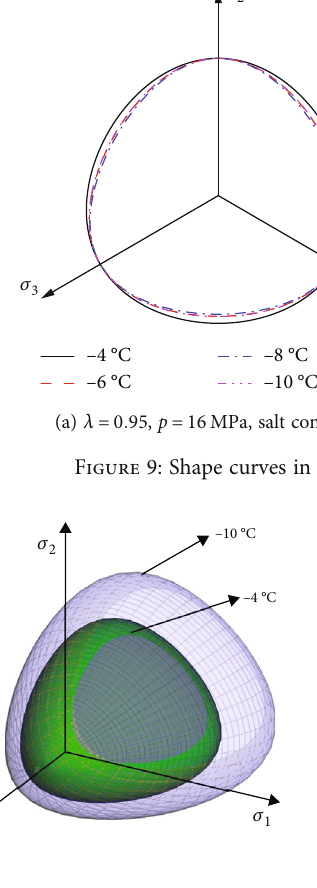
Figure 10: Failure surfaces for frozen samples with 1.5% salt content at various temperatures in principal stress space.